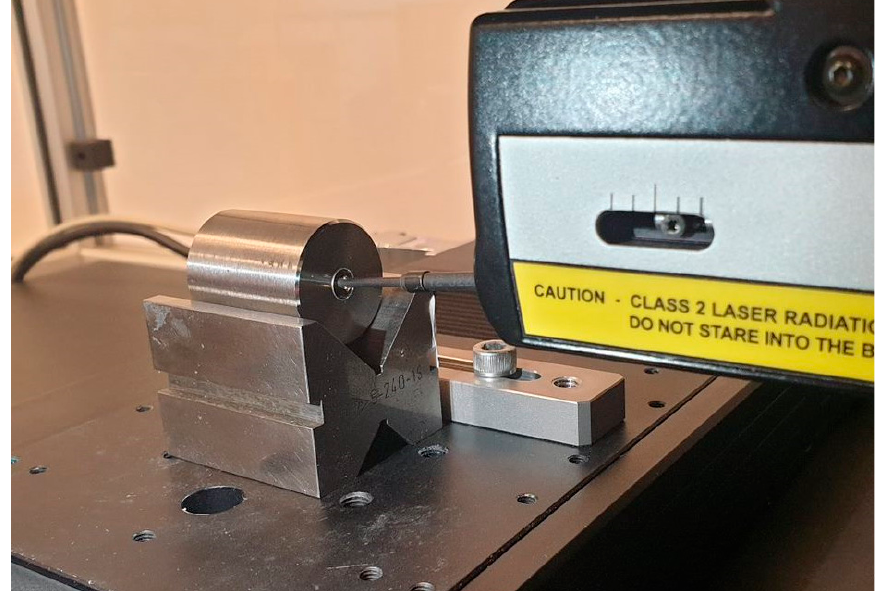
Figure 5. Workpiece clamping in the Form Talysurf PGI 1230.